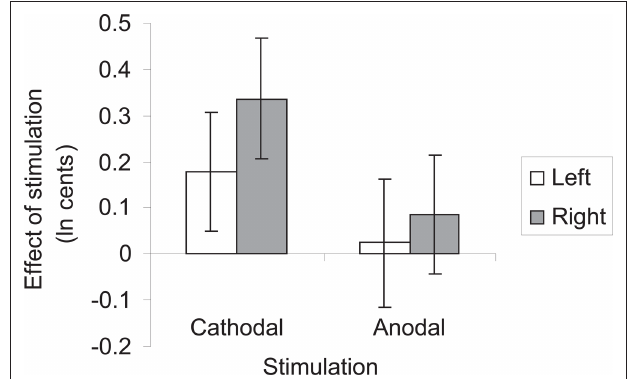
Figure 2 | Summary of results of ANCOVA. Bars represent mean subjects’ performance after cathodal and anodal stimulation over left and right Heschl’s gyrus, after correcting for learning/habituation effects. Error bars represent 95% confidence